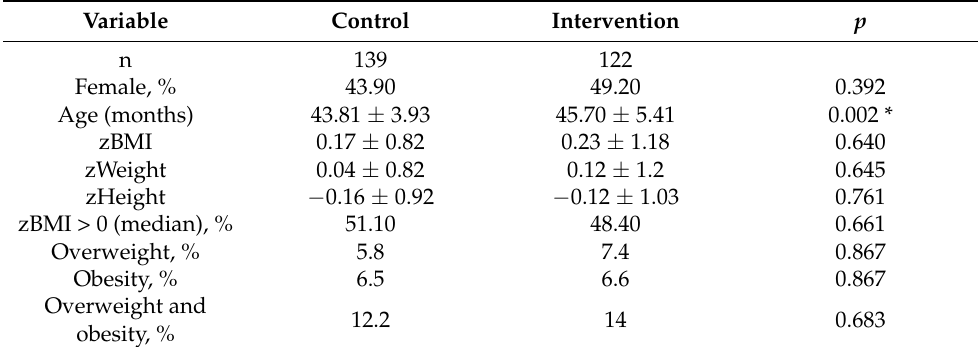
Table 1. Characteristics of the participants at the beginning of the